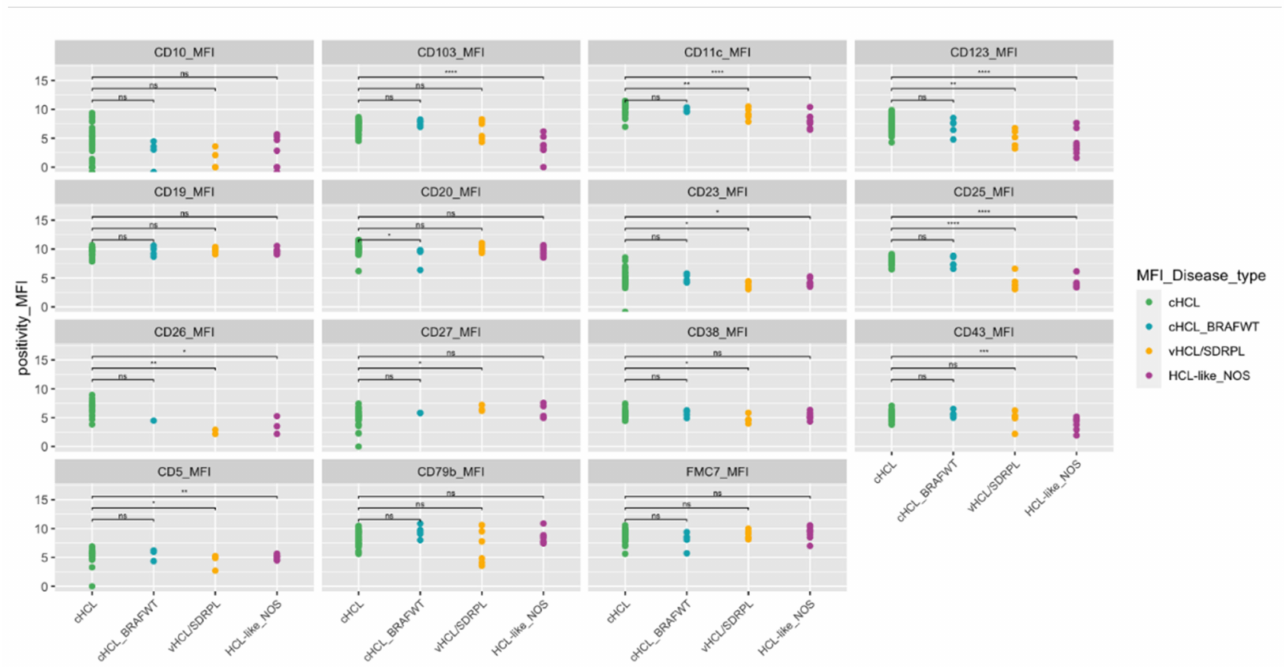
Figure 1. Phenotypic characteristics of the patients. Median fluorescence for each marker tested (cHCL n = 62, cHCL BRAFWT n = 5, vHCL/SDRPL n = 5, HCL-like NOS n = 9). Brown line underline 20%.Abbreviations: cHCL: classical form of Hairy cell leukemia, vHCL: variant form of hairy cell leukemia, SDRPL: splenic diffuse red pulp lymphoma, HCL-like NOS: hairy cell leukemia like disease not otherwise specified, ns: not significant, *: p -value ≤ 0.05, **: p -value ≤ 0.01, ***: p -value ≤ 0.001, ****: p -value ≤